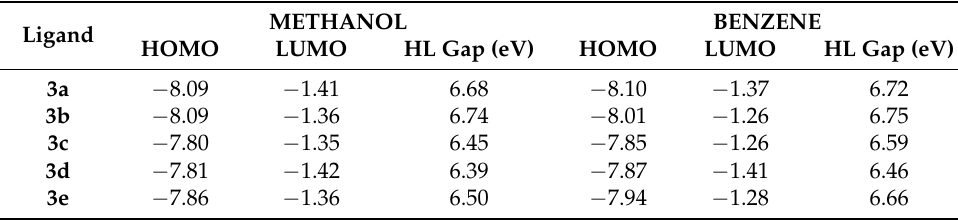
Table 4. The frontier orbital energy and energy gap (eV) of the investigated compounds.